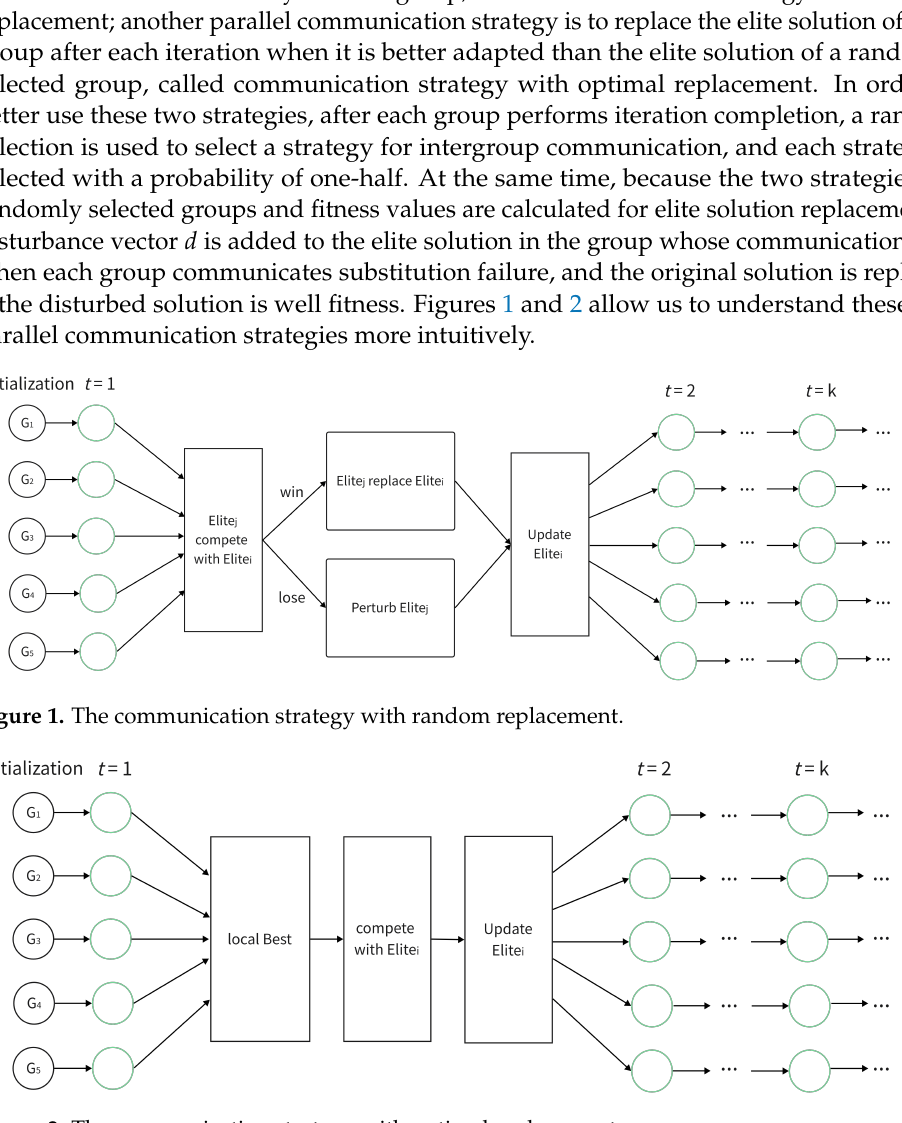
Figure 2. The communication strategy with optimal